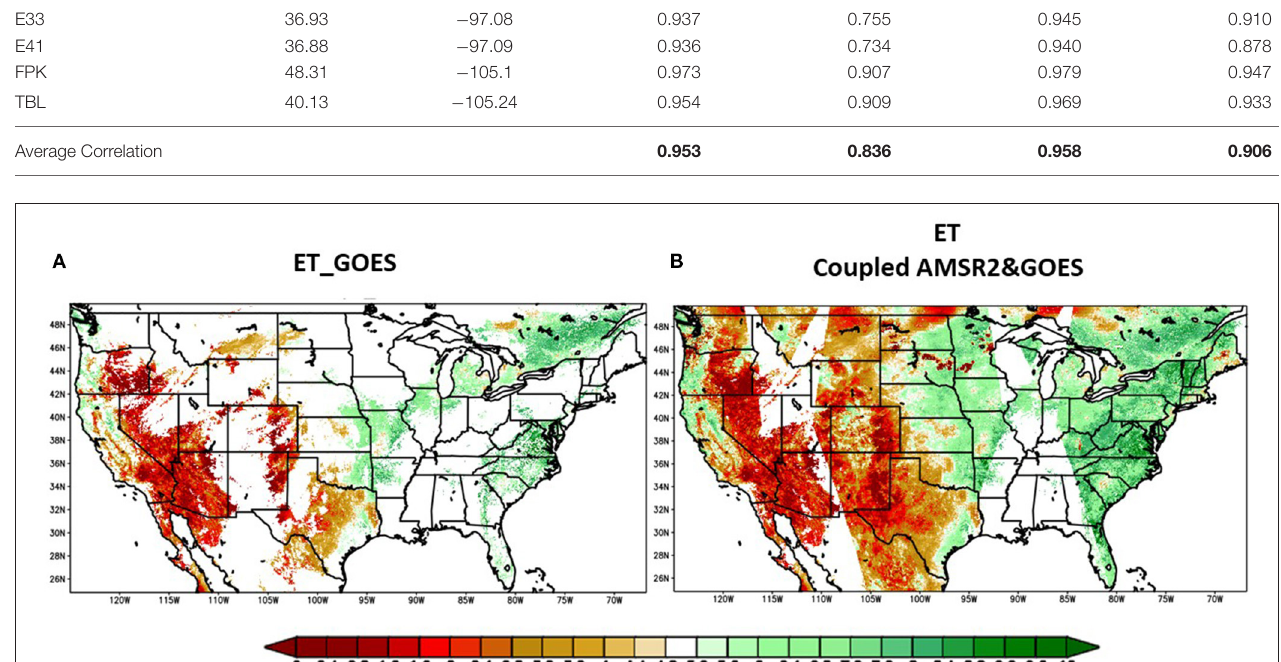
of Washington, North Dakota, South Dakota, Nebraska, and Minnesota are among the most cloud-contaminated areas and yet have been almost fully filled in by the all-weather ET